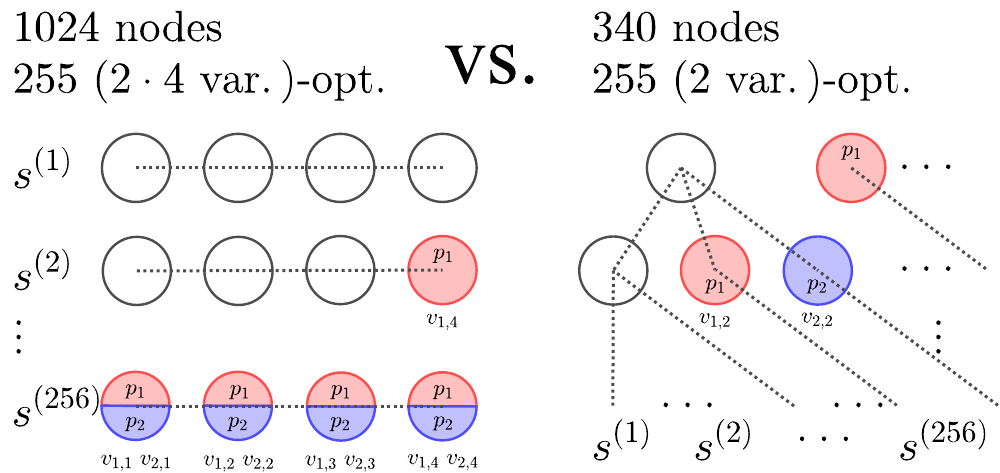
Figure 5. Variable speed optimization comparison for the pump operation ( n = 2, m = 4 ) . On the left hand side , each schedule s ∈ S is optimized with respect to at most n · m = 8 variables for speed v ∈ V . On the right hand side , optimization is performed at each colored node with respect to, at most, n = 2 variables. In both cases, the same number of optimization problems has to be solved (255), but, the problems to solve are simpler on the right hand side (two instead of eight variables). Red, blue and no color represent pumps p 1 and p 2 and no pump,